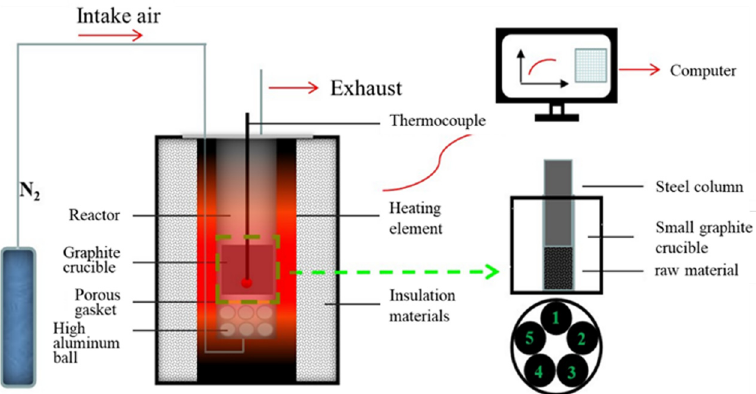
Figure 3. Schematic diagram of the high-temperature furnace.